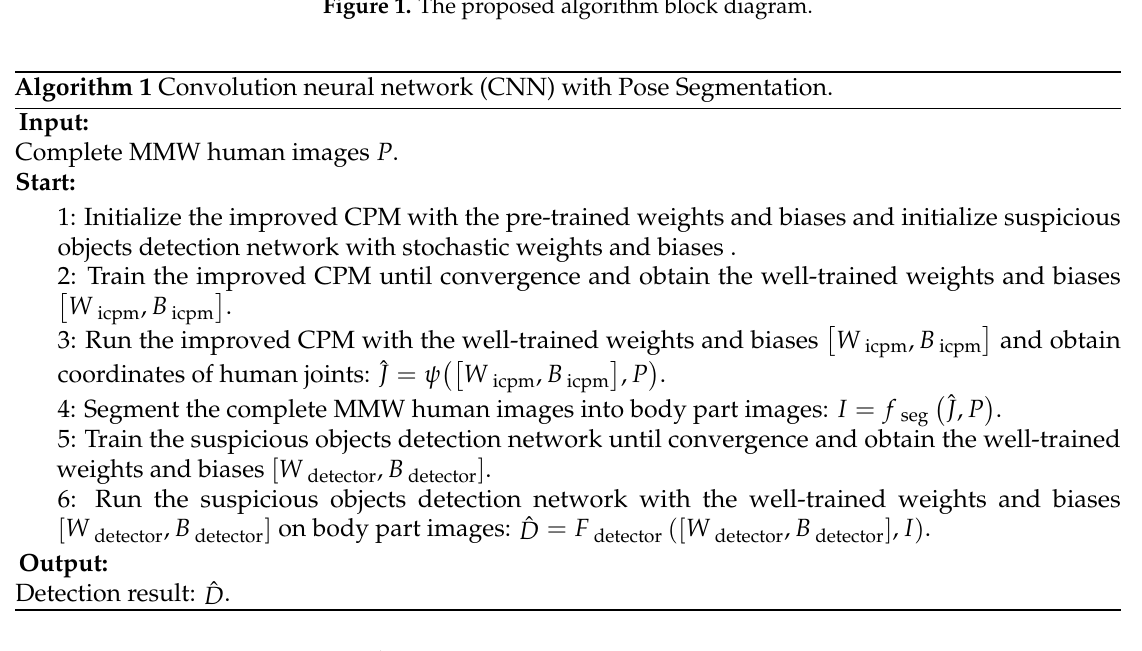
Figure 1. The proposed algorithm block diagram.